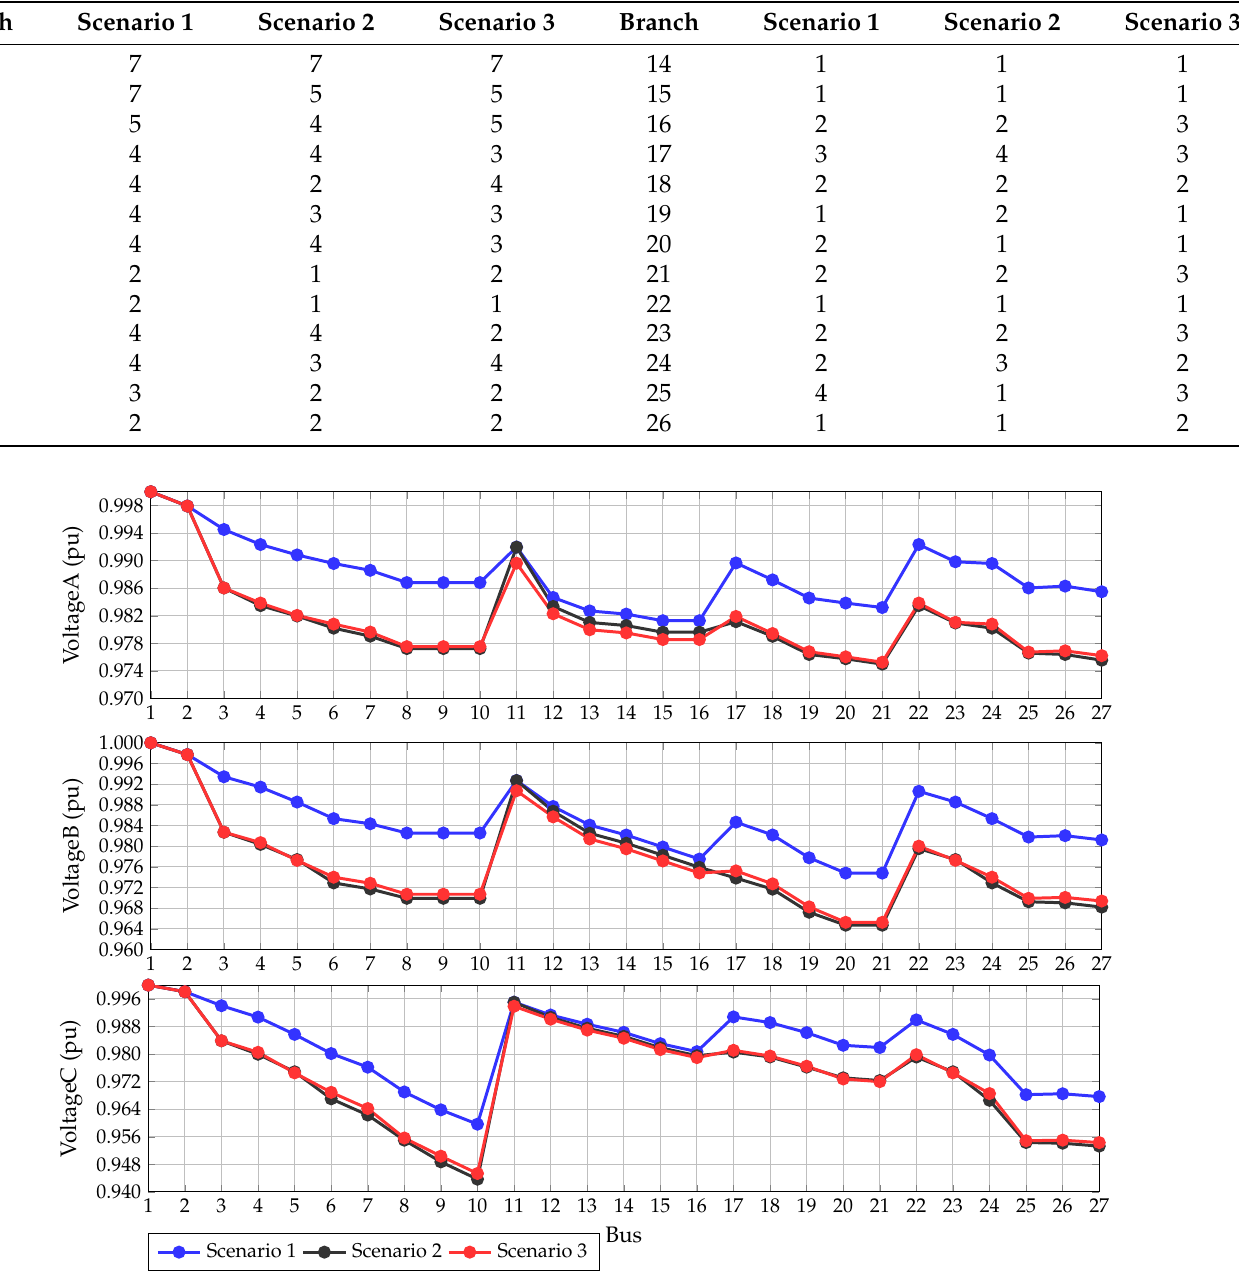
Table 19. Conductor selection test system 4.